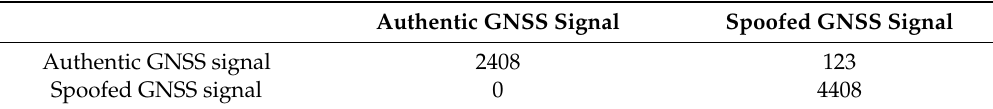
Table 4. Confusion matrix for the independent meaconing validation dataset in Experiment I. Table 5. Confusion matrix for the independent spoofing validation dataset in Experiment II.